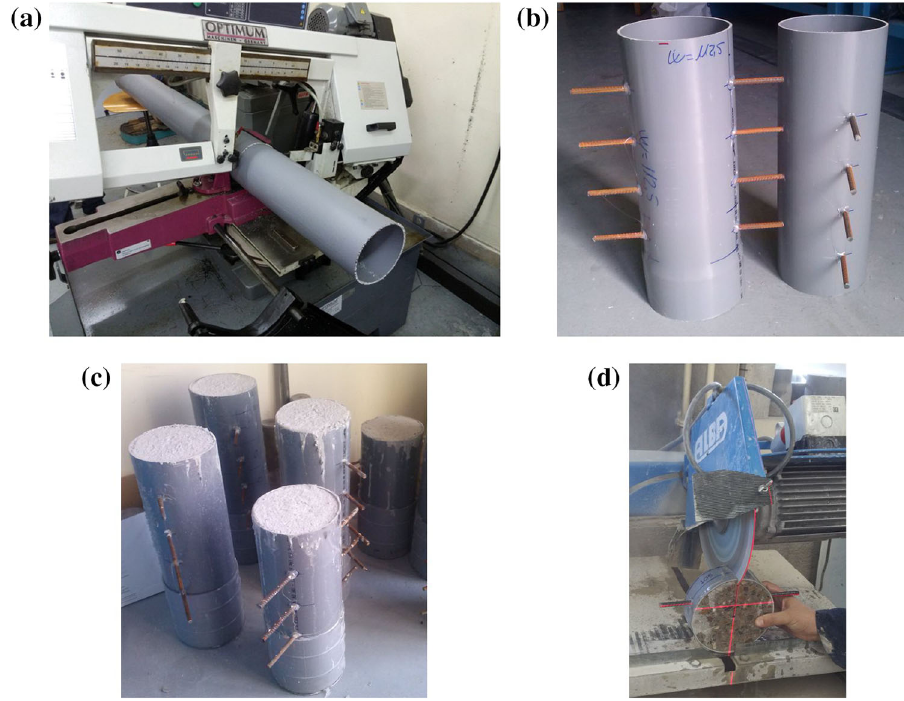
Fig. 5 Preparation of MDCT specimens. a Sawing PVC pipe tube. b Threaded pulling bars at regular distances. c Molds with casted concrete. d Mechanizing the